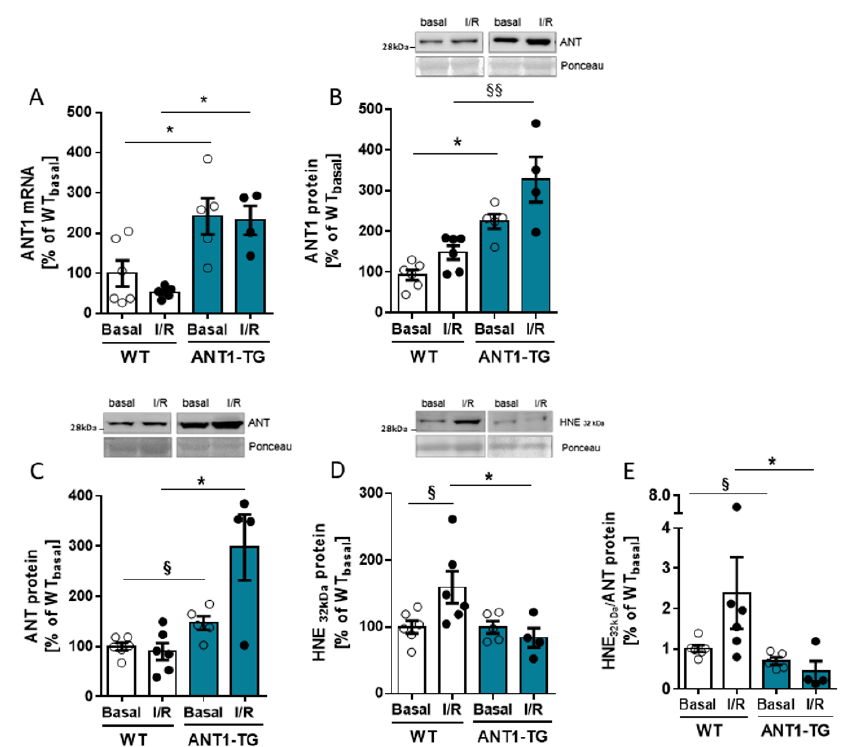
Figure 1. ANT expression and oxidative modification. Langendorff-perfused WT and ANT1-transgenic hearts were isolated after 15 min of basal perfusion (Basal) or after 45 min of ischemia, fol- lowed by two hours of reperfusion (I/R). Quantitative analysis of ( A ) ANT1 mRNA performed by real-time RT-PCR, ( B ) ANT1 protein, ( C ) total ANT protein, and ( D ) HNE-modified 32-kDa protein was done by Western blot analysis. The upper panels show representative Western blots, with Pon- ceau staining as the internal control. ( E ) The ratio between HNE 32kDa /total ANT protein, indicating the proportion of HNE-modified ANT protein. Data are presented as the mean ± SEM, * p < 0.05 using one-way ANOVA or Kruskal – Wallis with respective post hoc tests or § p < 0.05, §§ p < 0.01 using Mann – Whitney U test. 3.2. ANT1 Overexpression Stabilizes Mitochondrial Calcium Retention Capacity and Membrane Potential after I/R Mitochondrial dysfunction is central to the pathogenesis of I/R injury, caused by a sudden increase in the permeability of the inner mitochondrial membrane due to the per- sistent opening of the MPTP, resulting in caspase activation. ANT1 is a regulator of the MPTP. The calcium-induced opening of the MPTP can be determined by the calcium re- tention capacity (CRC) of mitochondria. I/R treatment reduced the Ca 2+ concentration re- quired for MPTP opening in WT but not ANT1-TG mitochondria, seen by lower numbers of calcium uptakes during the measurement (Figure 2A – C). Cyclosporin A (CsA), an MPTP inhibitor, increased the Ca 2+ concentration to open the MPTP in all groups but reached statistical significance only for normoxic ANT1-TG mitochondria. Even under CsA-mediated MPTP inhibition, the ANT1-TG mitochondria required higher calcium concentrations to initiate MPTP opening than WT mitochondria after I/R. This finding in- dicated that ANT1-TG are more resistant to calcium overload than WT mitochondria. The decrease in CRC in I/R WT mitochondria was linked to the increased expression of active caspase 3 protein in the heart tissue (Figure 2D).